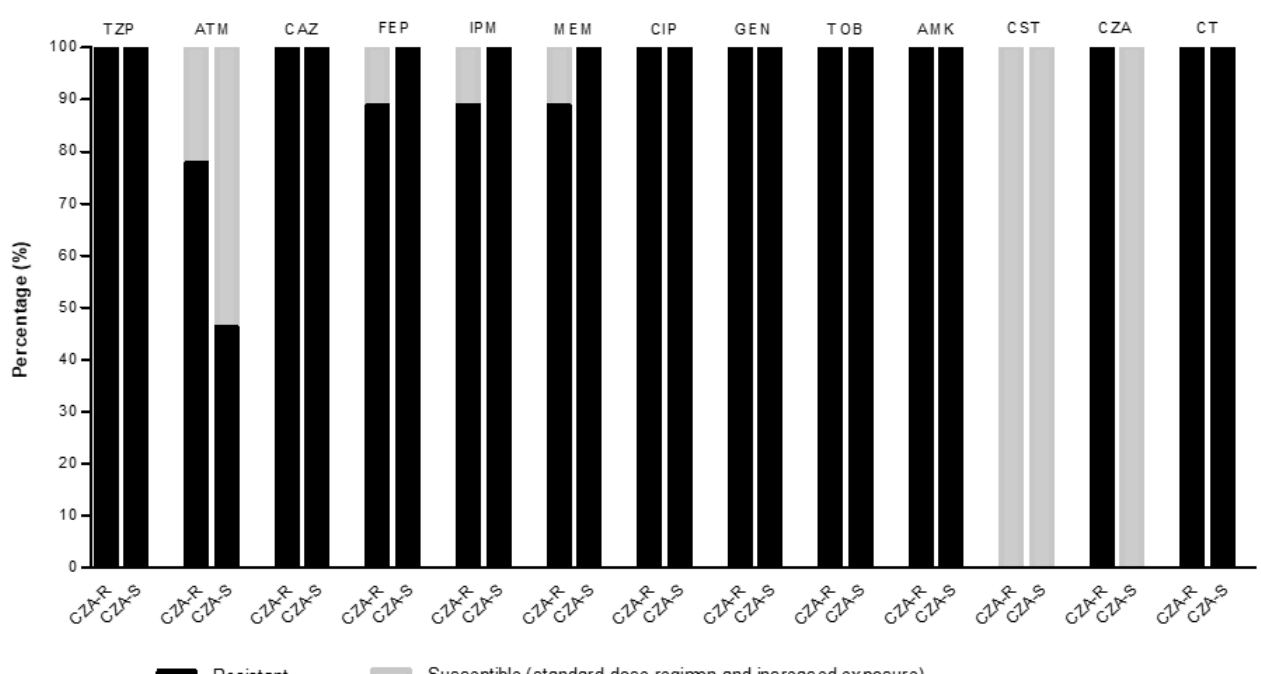
Figure 1. Antimicrobial susceptibility of ceftazidime/avibactam (CZA)-resistant ( n = 9) and CZA- susceptible ( n = 13) P. aeruginosa isolates. Ceftolozane/tazobactam and CZA minimum inhibitory concentrations (MICs) were determined by gradient strips. Percentages of resistant and susceptible (standard dose and incremented exposure) isolates were calculated using the European Committee on Antimicrobial Susceptibility Testing (EUCAST) v.10. 0 (2020) clinical breakpoints. TZP, piperacillin/tazobactam; ATM, aztreonam; CAZ, ceftazidime; FEP, cefepime; IPM, imipenem; MEM, meropenem; CIP, ciprofloxacin; GEN, gentamicin; TOB, tobramycin; AMK, amikacin; CST, colistin; CZA, ceftazidime/avibactam; CT,